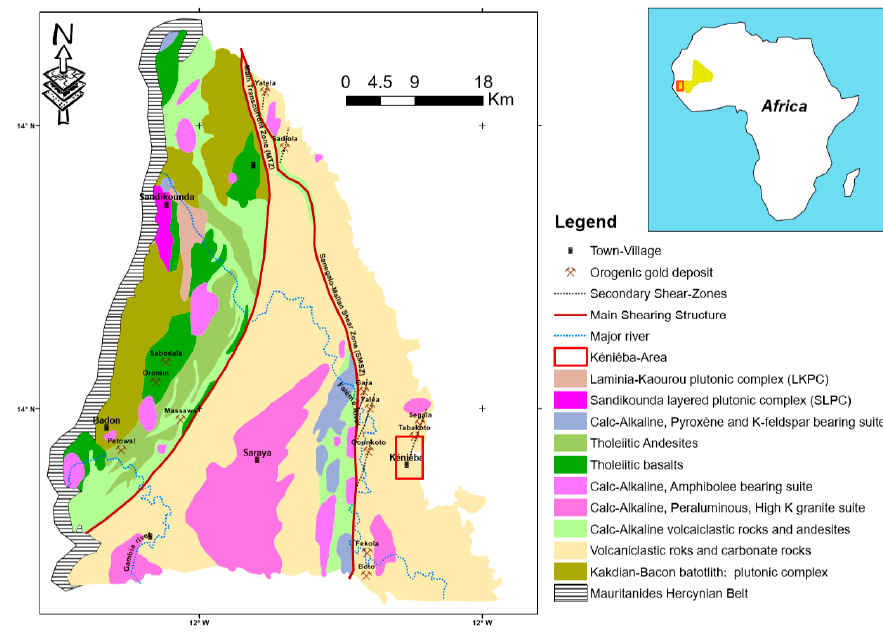
Figure 2. Geological map of Kédougou-Kéniéba Inlier (KKI) ([4], simplified]).